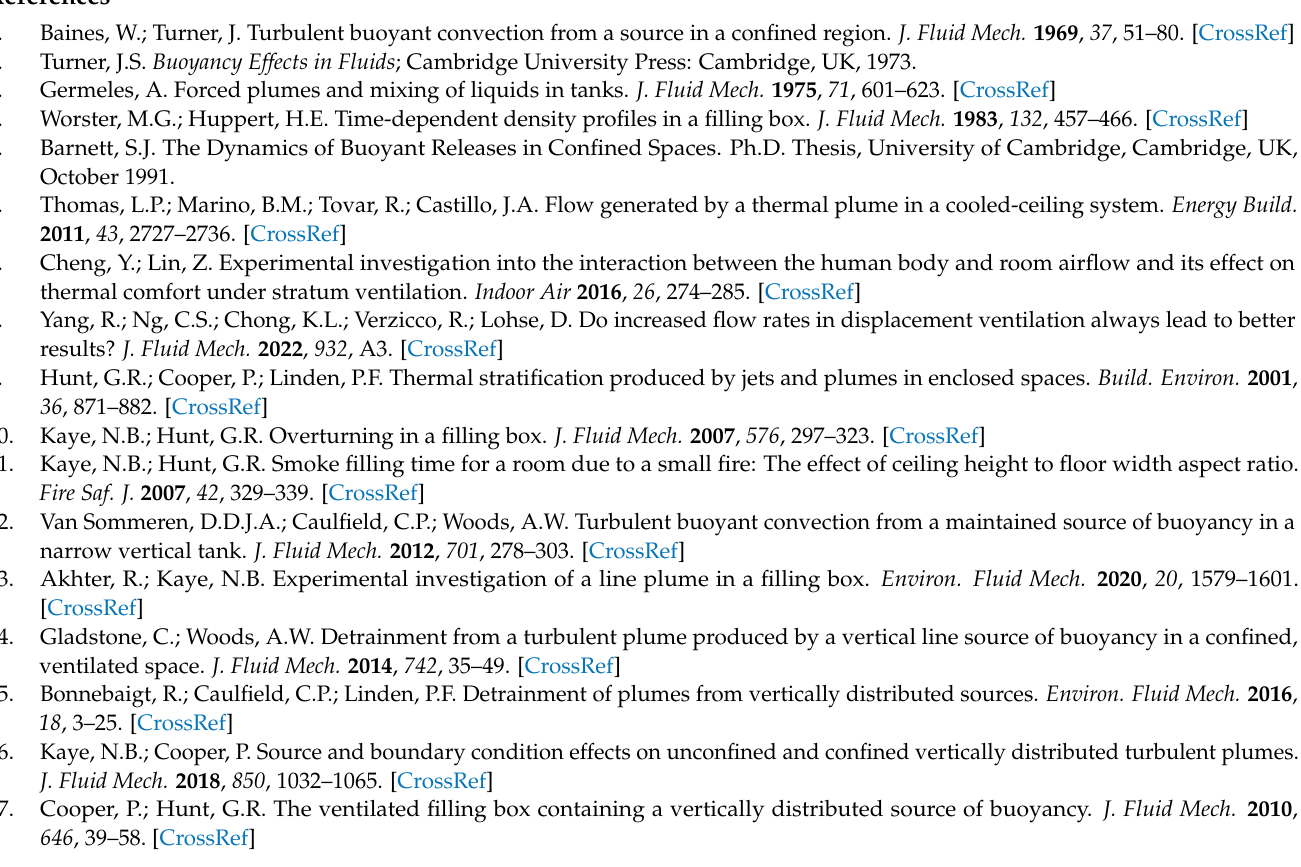
Figure A2. Inclined plane buoyant jet cases in linearly stratified environments: ( a ) Comparison of predicted to measured values of the normalised level 𝑍 (cid:3046) = (𝑧 (cid:3046) /𝐷)𝐹 (cid:2868)(cid:2879)(cid:2872)/(cid:2871) of the spreading layer; and ( b ) comparison of predicted to measured values of the normalised dilution 𝑆 ∗ = 𝑆𝐹 (cid:2868)(cid:2879)(cid:2870)/(cid:2871) . Consequently, EMA can be satisfactorily to simulate either vertical or inclined plane buoyant jets in stratified environments.